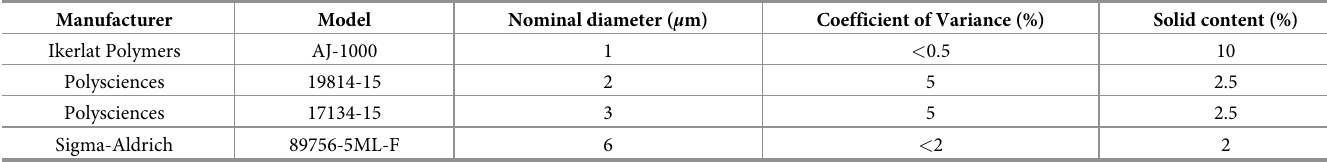
Table 2. Main characteristics of the commercial suspensions of polystyrene microspheres used in the validation experiments.